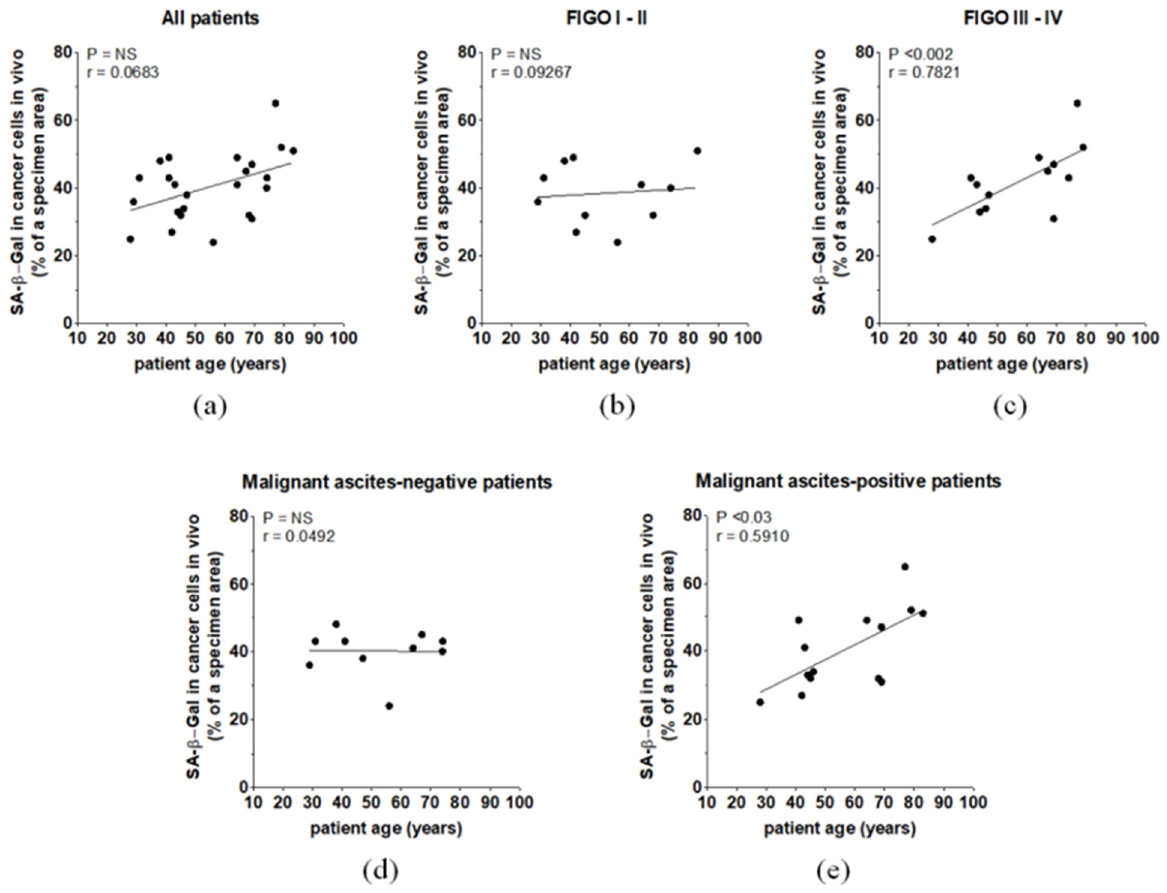
Figure 3. The relationships between ovarian patient age and SA- β -Gal level in the whole cohort ( a ), patients with different FIGO stages ( b , c ), and patients with different malignant ascites statuses ( d , e ).